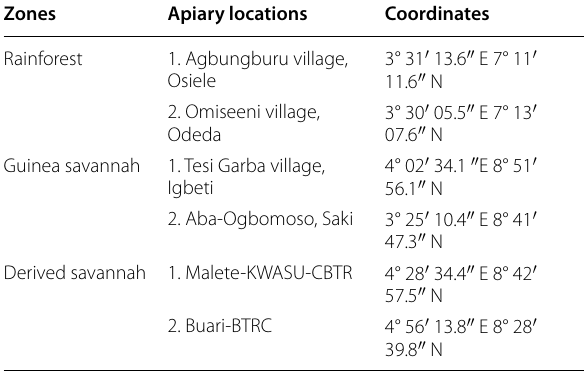
Buari-BTRC Beekeeping Training and Research Centre, Buari, Ifelodun Local Government, Kwara State; KWASU-CBTR Kwara State University Centre for Beekeeping Training and Research, Malete, RF Rainforest, GS Guinea savannah, DS Derived savannah